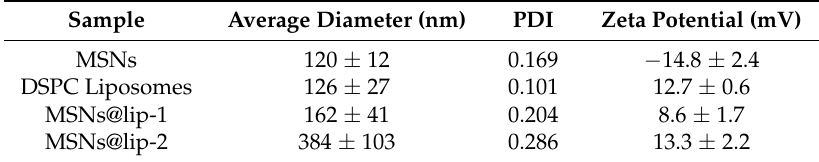
Table 1. The average diameter and Zeta potential of MSNs, DSPC liposomes, MSNs@lip-1 and